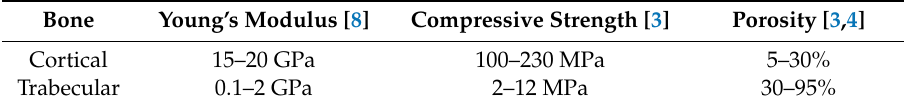
Table 1. The native bone tissue physical characteristics, relevant for bone tissue